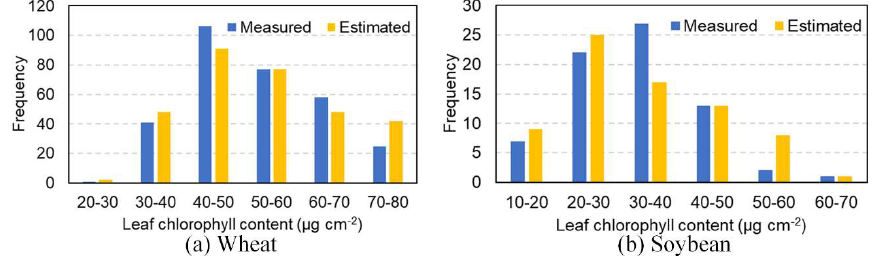
Figure 10. The distributions of measured and estimated LCC for: ( a ) wheat; and ( b ) soybean.